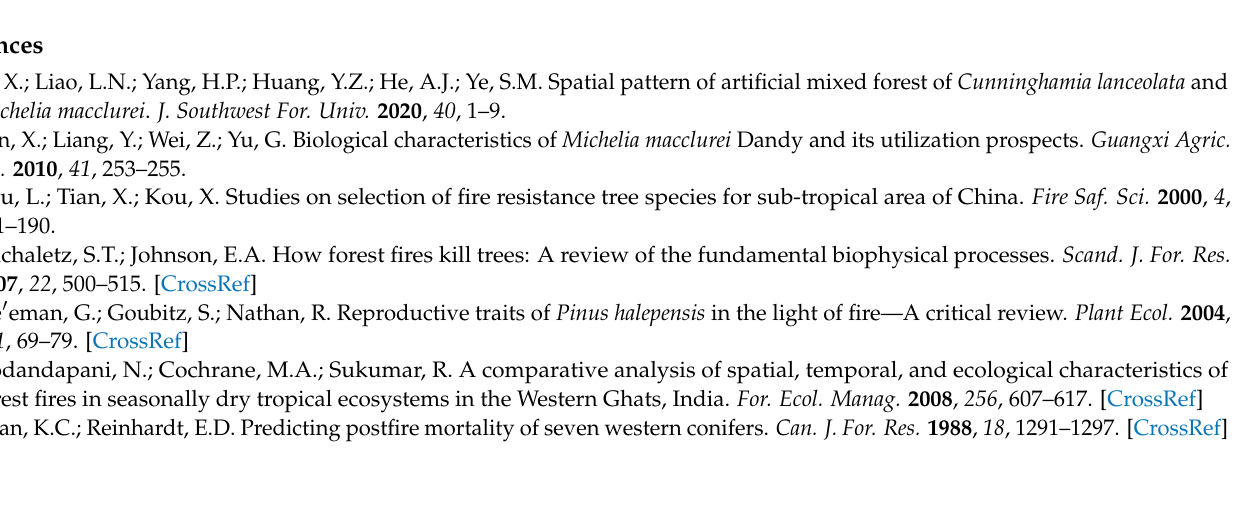
S1: Primers used for qRT-PCR analysis. Table S2: Summary of RNA-Seq data in Michelia macclurei . Table S3: Annotation of unigenes in different samples. Table S4: Differentially expressed genes under heat stress in Michelia macclurei. Table S5: KEGG enrichment information of differentially expressed